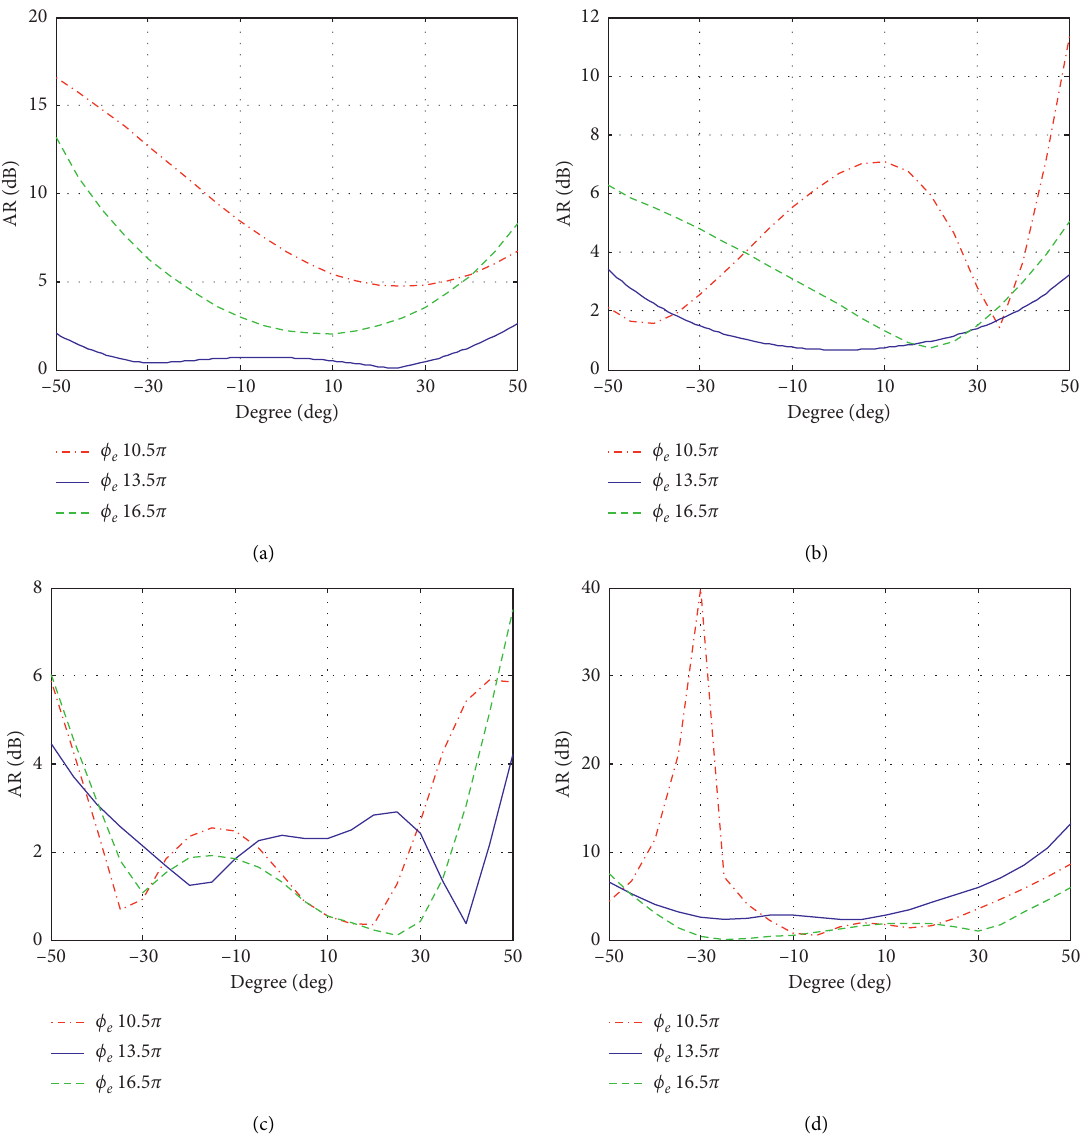
Figure 7: The simulated AR with different φ e . (a) xoz plane at 1GHz. (b) yoz plane at 1 GHz. (c) xoz plane at 6GHz. (d) yoz plane at 6